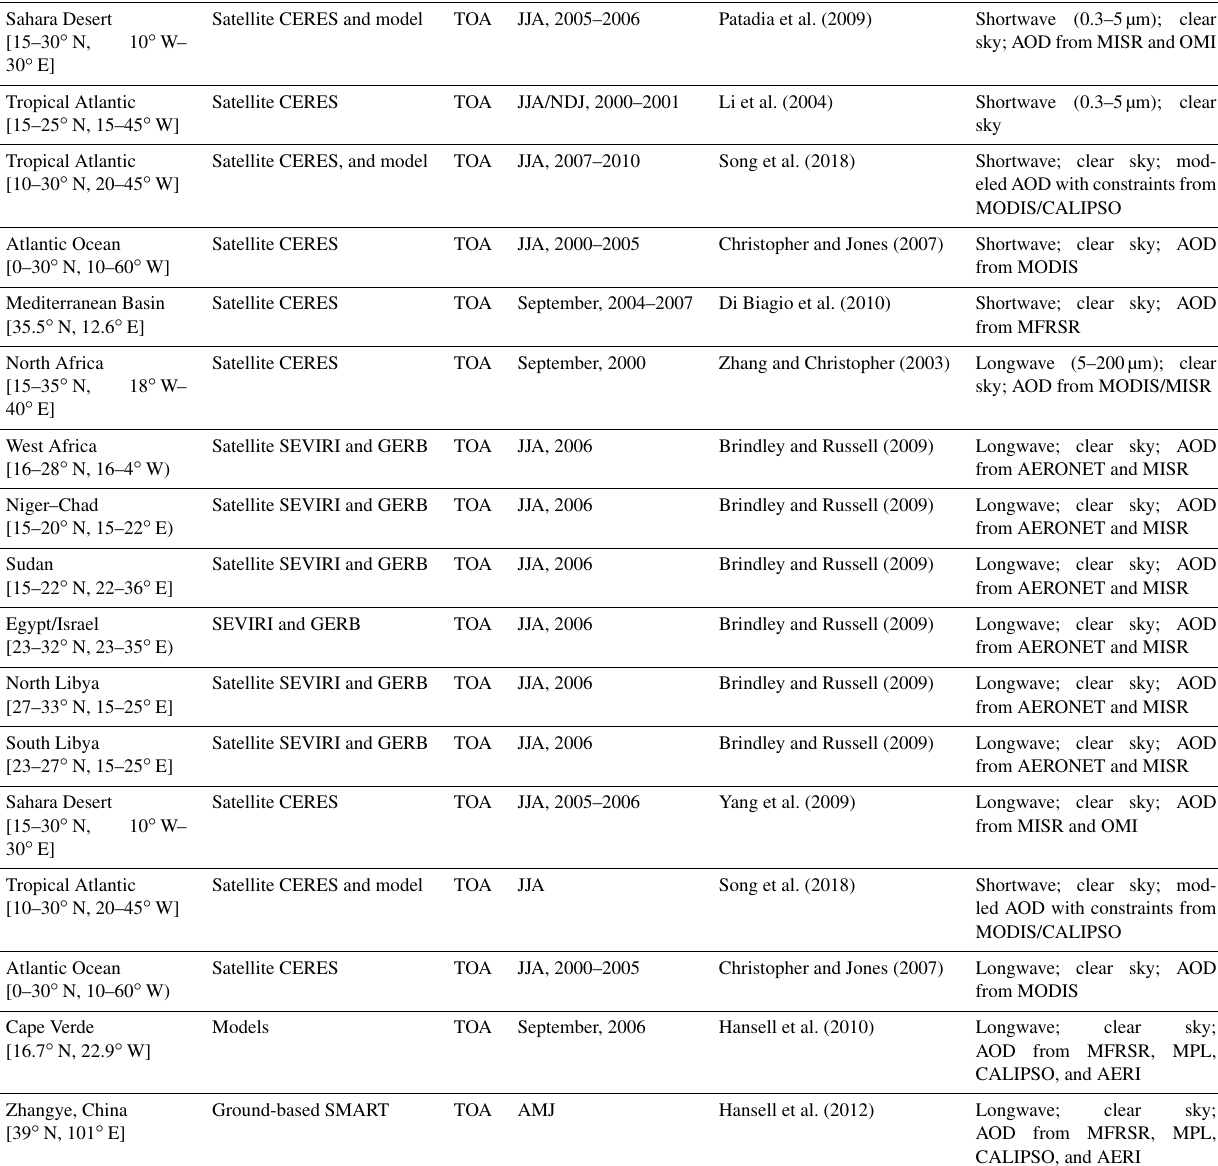
Table 5. Retrieved dust direct radiative effect efficiency (DREE) for model evaluations. CERES: Clouds and the Earth’s Radiant Energy Sys- tem; TOA: top of the atmosphere; JJA: June, July, and August; AOD: aerosol optical depth; MISR: Multi-angle Imaging SpectroRadiometer; OMI: Ozone Monitoring Instrument; NDJ: November, December, and January; MODIS: Moderate Resolution Imaging Spectroradiometer; CALIPSO: Cloud–Aerosol Lidar and Infrared Pathfinder Satellite Observations; MFRSR: MultiFilter Rotating Shadowband Radiometer; SEVIRI: Spinning Enhanced Visible and Infrared Imager; GERB: Geostationary Earth Radiation Budget; AERONET: Aerosol Robotic Network; MPL: micro-pulse lidar; AERI: Atmospheric Emitted Radiance Interferometer; SMART: Surface-sensing Measurements for At- mospheric Radiative Transfer; AMJ: April, May, and